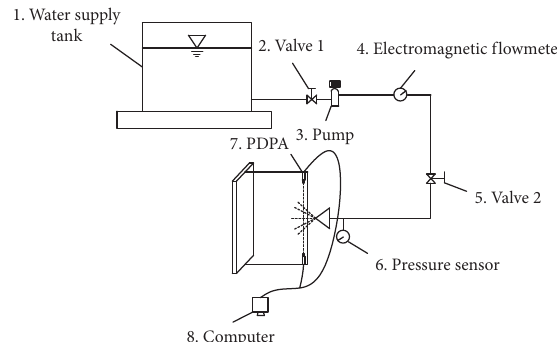
Figure 7: Diagram of the atomizing nozzle test